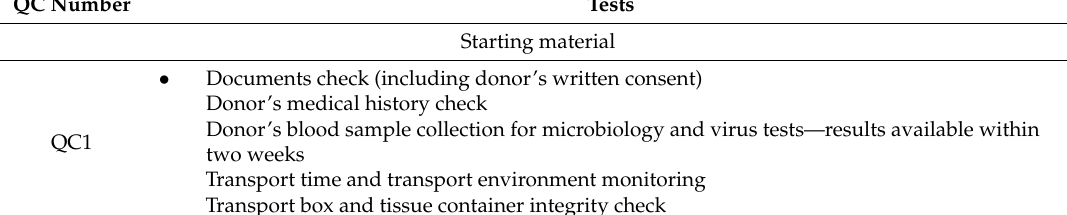
Table 4. Quality controls for bioprocessing of mesenchymal stem cell-derived extracellular vesicles. QC Number Tests